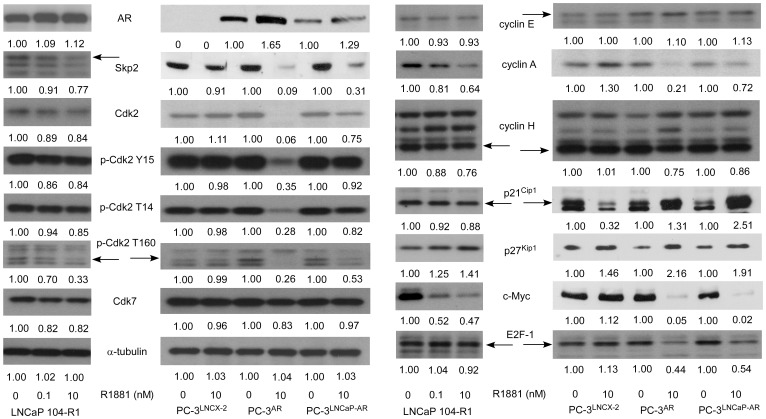
Effects of androgen on cell cycle-regulatory proteins in LNCaP 104-R1, PC-3LNCX-2, PC-3AR, and PC-3LNCaP-AR cells.Protein expression of AR, Skp2, Cdk2, phospho-Cdk2 Tyr15, phospho-Cdk2 Thr14, phospho-Cdk2 Thr160, Cdk7, cyclin E, cyclinA, cyclin H, p21cip, p27Kip, c-Myc, and E2F-1 was determined by Western blotting assay in LNCaP 104-R1, PC-3LNCX-2, PC-3AR, and PC-3LNCaP-AR cells treated with different concentration of R1881 for 96 h. Protein abundance of α-tubulin was used as loading control.